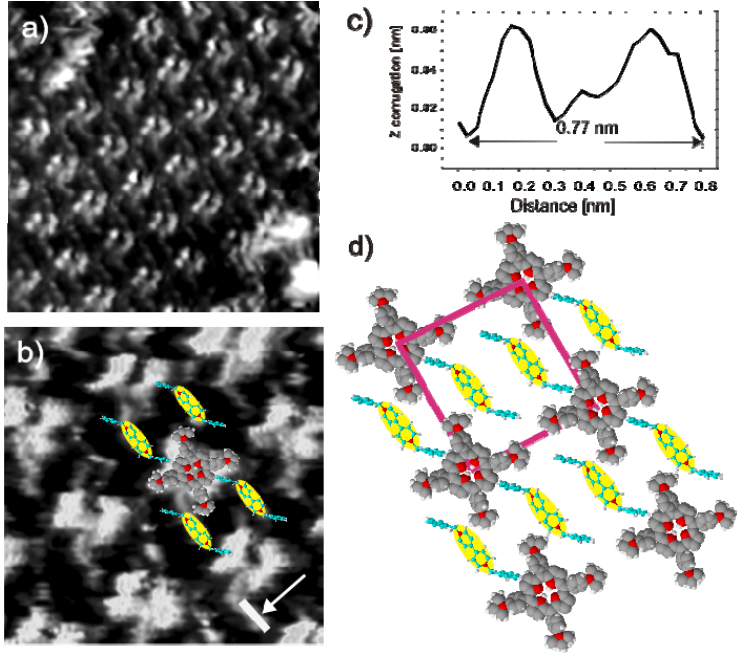
Figure 14. Typical medium scale and high resolution STM images of a mixed phase in TTMAPP] 4+ molecules are recognized as bright squares and the DBV 2+ which the [H 2 = +323 mV, I = 0.1 nA, E = +30 mV; ( a ) 12.82 nm × 12.82 nm; molecules as rodlets: U b t ( b ) 5.60 nm × 5.60 nm; ( c ) Line profile along the white bar in panel b (indicated by the arrow) representing the length of the bipyridinium core of a DBV cation; ( d ) Possible model for the mixed phase on